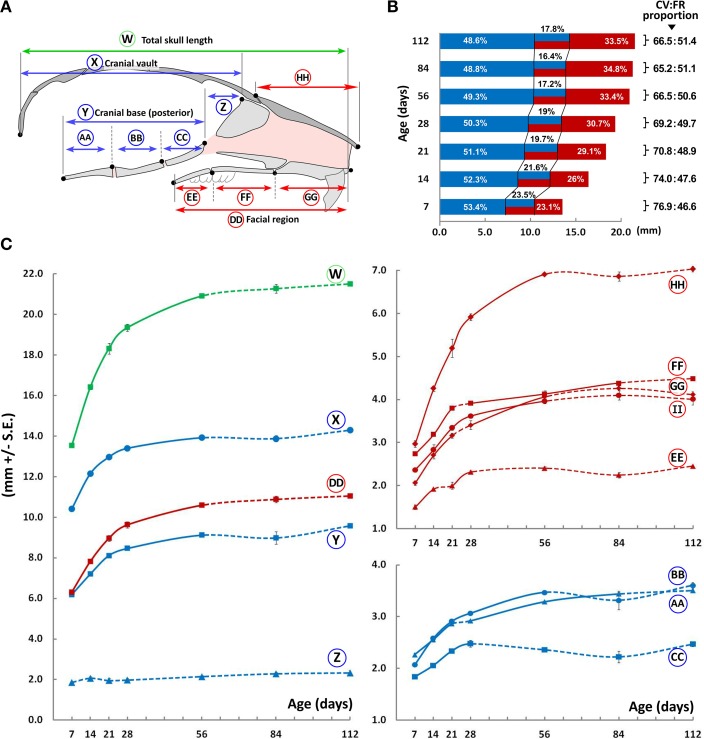
Antero-posterior growth of the mouse craniofacial skeleton. (A) Schematic of the mid-sagittal structures of the mouse skull depicting landmarks (black dots) and planes (vertical lines) used to obtain measurements in the cranial (blue) and facial (red) regions (see Methodology, Figure 1). (B) Bar graph depicting growth of the cranial vault (blue) and facial region (red) as well as the overlap (blue/red) between them (see A for schematic of each region). Numbers next to square parenthesis indicate the proportions of the entire A-P dimension of the skull occupied by the cranial vault and facial regions, inclusive of the overlap between them (CV:FR proportion); while numbers within the bar graph indicate the proportion (percentage) of each region adjusted for overlap (i.e., cranial vault, overlap, and facial regions). (C) Growth curves showing changes in A-P measurements of individual bones or facial regions (mm ± S.E., y-axis) with age (postnatal day, x-axis). The label adjacent to each curve is depicted in the schematic shown here and in Figure 5A (see Table 1 for description). Solid and dashed lines between data points represent significant and non-significant changes, respectively, for that interval (Students' t-test, p < 0.05).